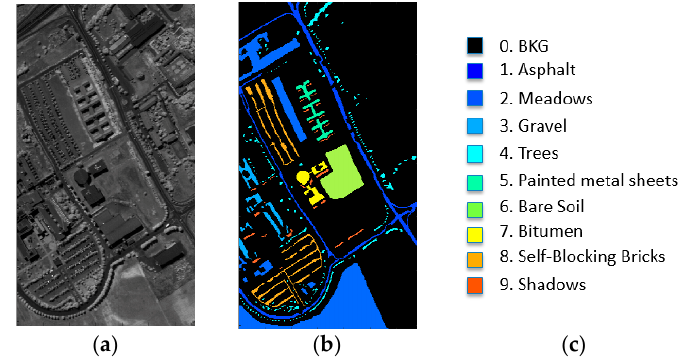
Figure 3. Ground truth of University of Pavia scene with nine classes. ( a ) Band 95, ( b ) color ground truth image, ( c ) class labels.